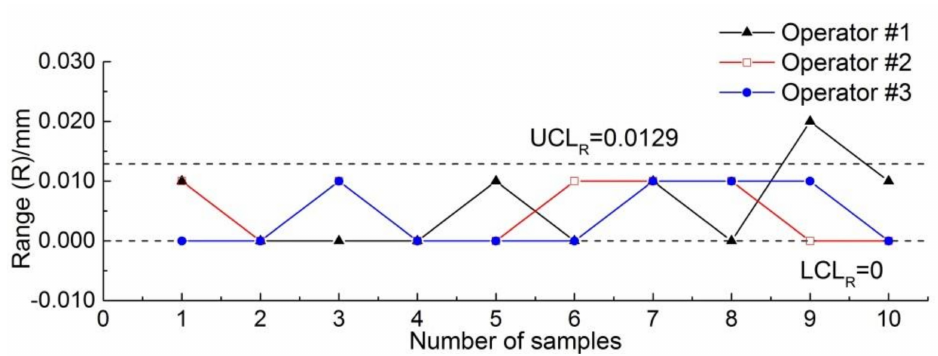
Figure 13. The relationship between sample number, range, and different operators. UCL R : upper control limit of the range; LCL R : lower control